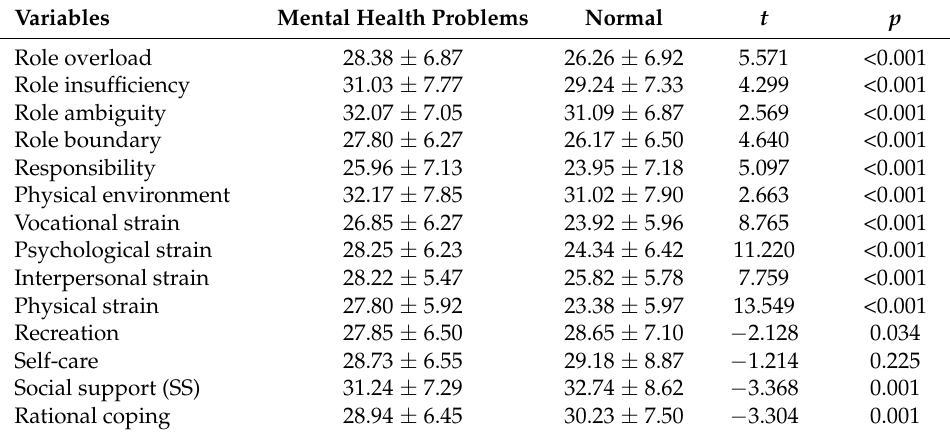
Table 3. Comparison of occupational stress variables between the two groups ( χ ± s ).